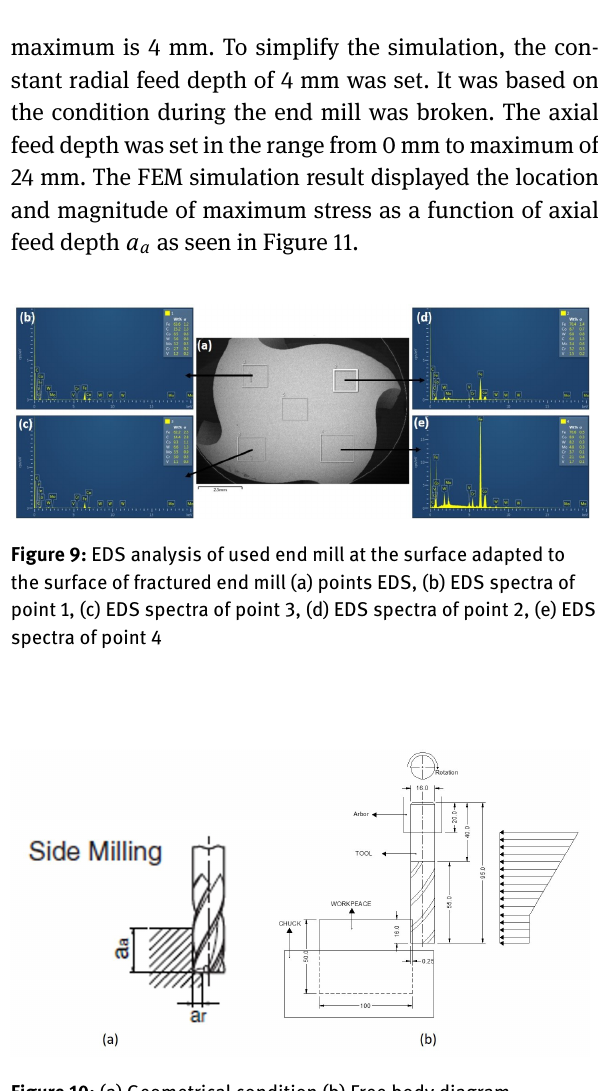
Figure 10: (a) Geometrical condition (b) Free body diagram.